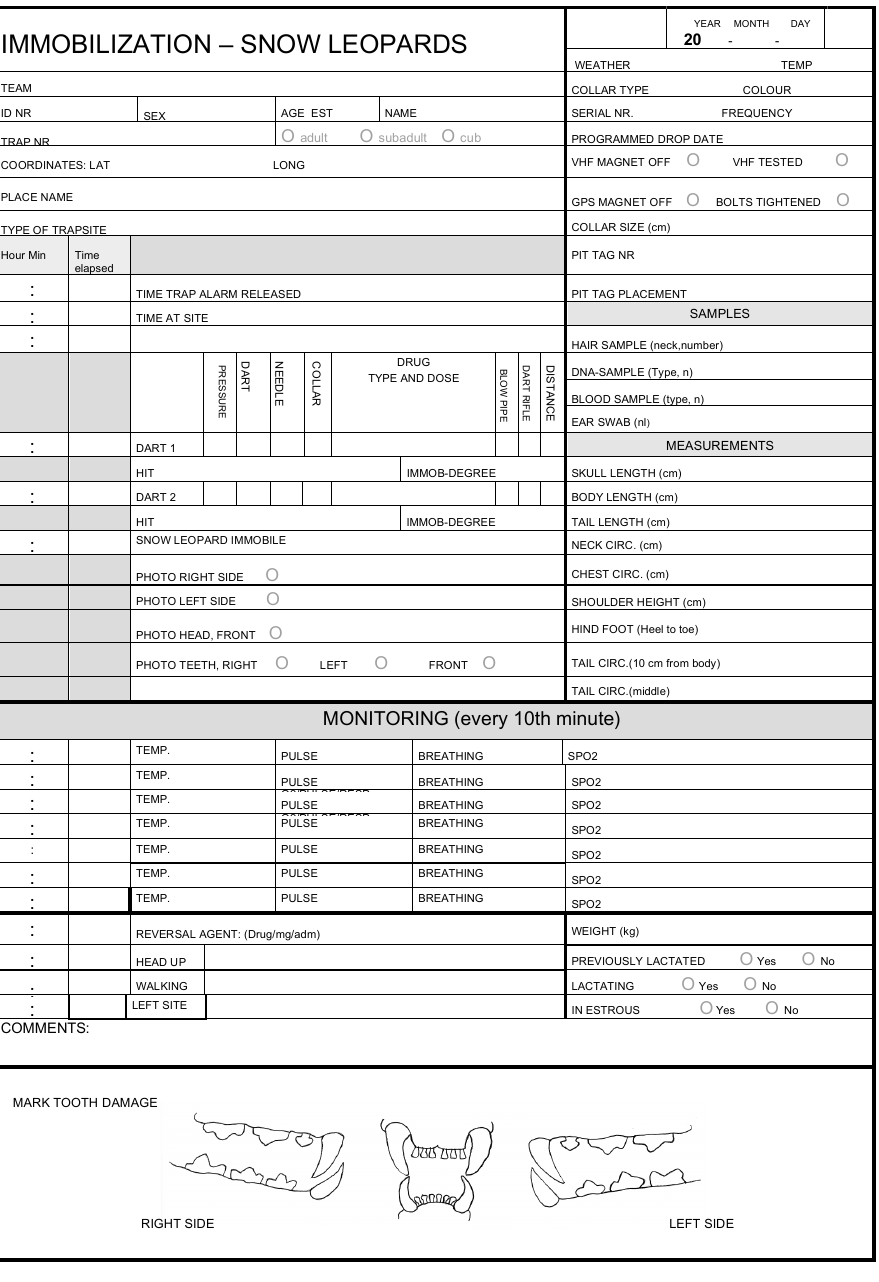
Figure 2. Example of a capture form used to ensure that all data is recorded and monitoring conducted at the intervals specified in the research plan. The capture form can be found as a Microsoft Word file in Supplementary Materials, Figure S1.